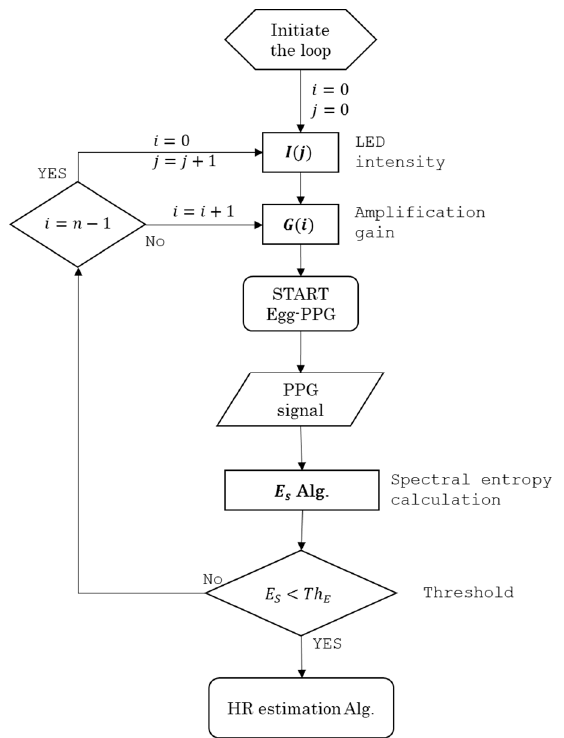
Figure 9. Flow chart shows the main steps of the developed cardiac signal detection algorithm based on spectral entropy ( (cid:1831) (cid:3020)